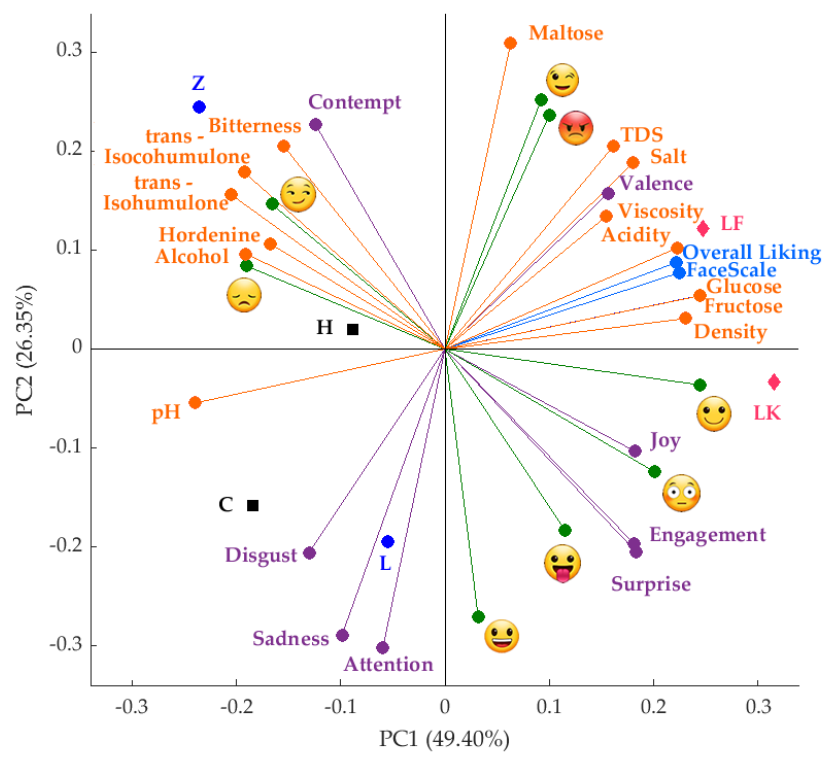
Figure 2. Principal components analysis showing the results from the sensory (self-reported liking responses in blue), biometrics (purple for emotions, and green for the emojis generated from the facial expressions), and chemical data (orange). Abbreviations: PC1 and PC2 = principal component 1 and 2, TDS = total dissolved solids. Abbreviations for samples are shown in Table 1.